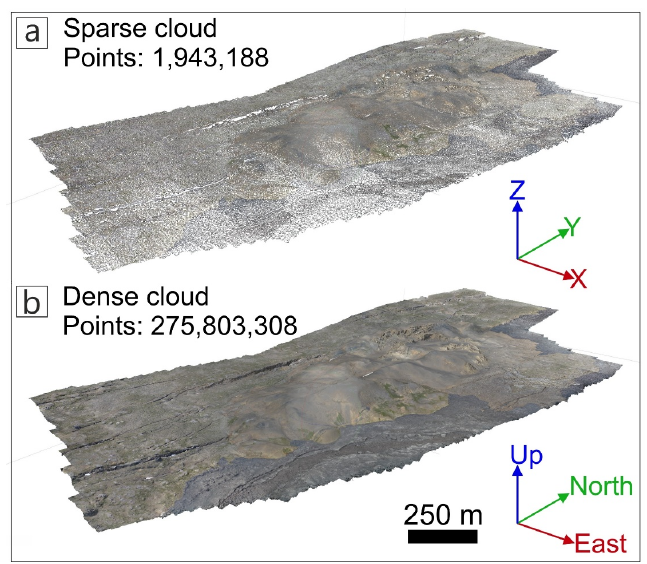
Figure 4. Snapshots of the steps performed with the SfM software to obtain the final outputs of our workflow, consisting in the calculation of sparse point clouds ( a ) and dense point clouds ( b ). Appl. Sci. 2020 , 10 , x FOR PEER REVIEW